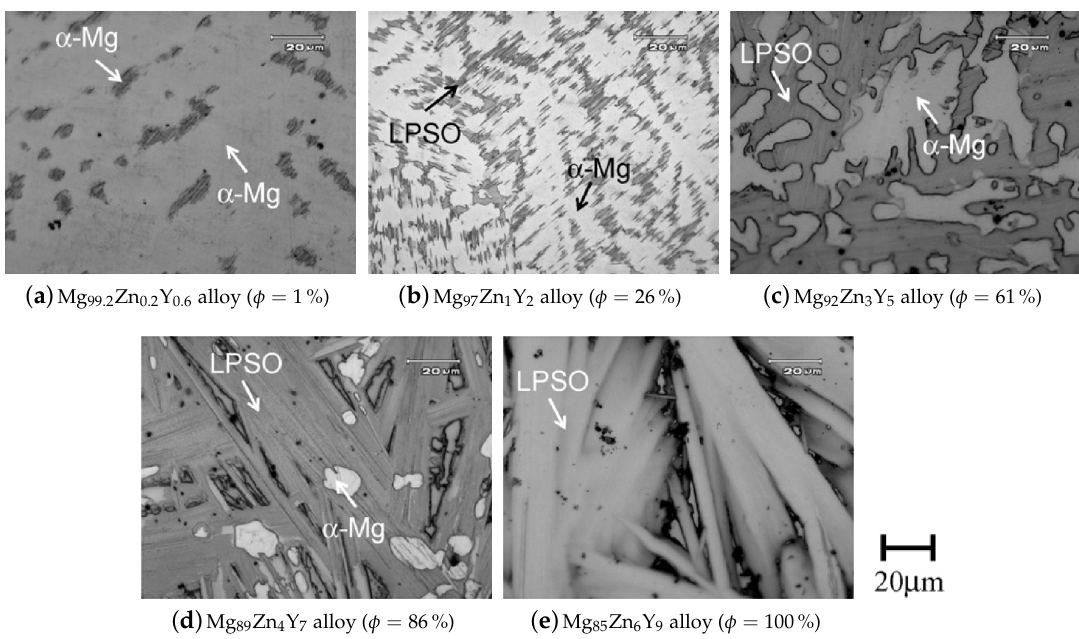
Figure 27. Microstructure of as-cast Mg-Zn-Y alloys with varying long period stacking order (LPSO) volume fraction ( φ ) [144]. The scale bar applies to all figures ( a – e ). Reproduced with permission from